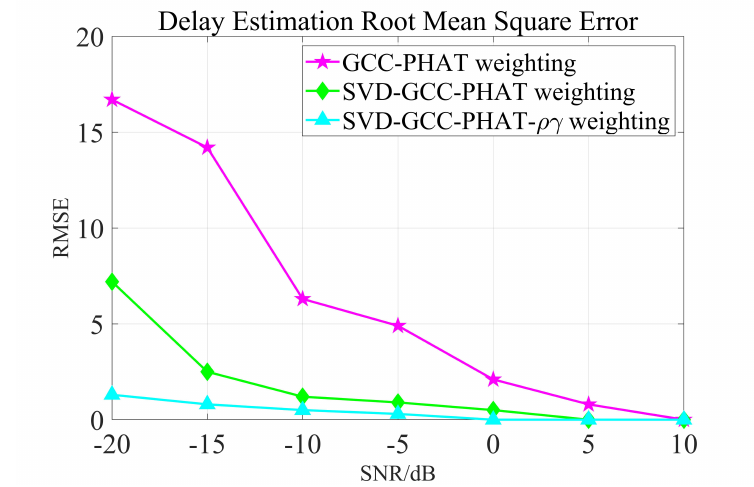
Figure 11. RMSE of three methods for delay